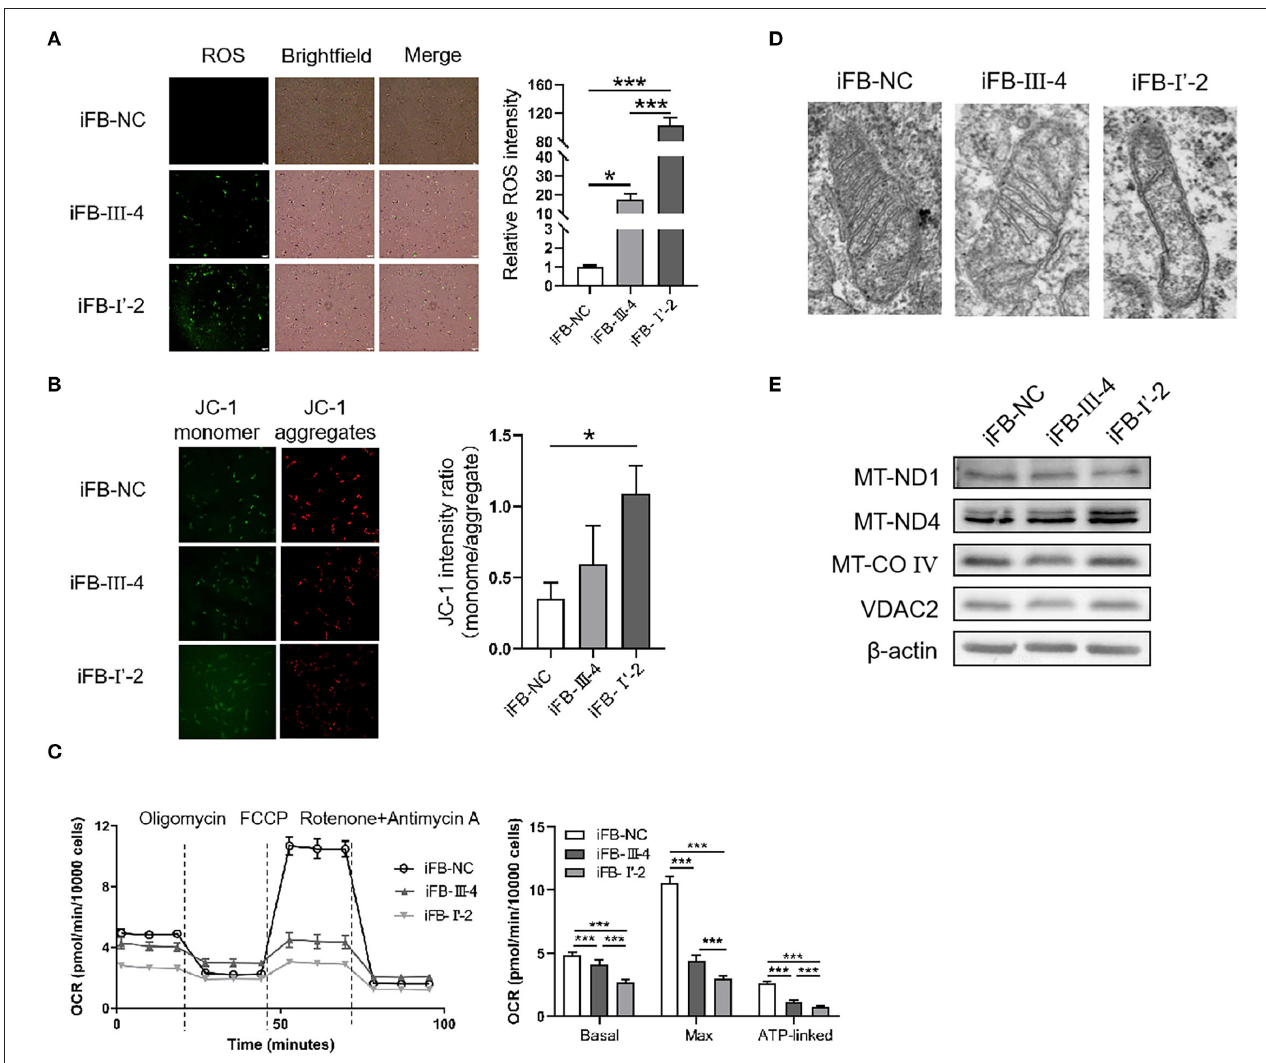
FIGURE 3 | Mitochondria damaged severely in immortal fibroblast (iFB)-LHON cells with more variants. (A) ROS level was detection in different fibroblast cell lines: iFB-NC, iFB-III-4, and iFB-I’-2. * p ≤ 0.05, *** p ≤ 0.001. (B) JC-1 monome and aggregate were pictured. The ratio of fluorescence intensity between monomer and aggregate characterized mitochondrial membrane potential. * p ≤ 0.05. (C) oxygen consumption rate (OCR) value of three fibroblast cells was detected using seahorse. The basal (OCR value = OCR value at the beginning, meaning the level of energy metabolism rate in basal state), max (OCR value = OCR value at the highest point after FCCP treatment, meaning the maximum respiration rate that the cell can achieve) and ATP-linked (OCR value = OCR value decreased after oligomycin treatment, meaning the respiration part used for ATP synthesis) OCR values were calculated. *** p ≤ 0.001. (D) Mitochondrial morphology in iFB-NC, iFB-III-4, and iFB-I’-2 cells was photographed by electron microscope. (E) The protein levels of MT-ND1, MT-ND4, MT-CO IV, and VDAC2 were detected by Western blot. The β -actin was used as